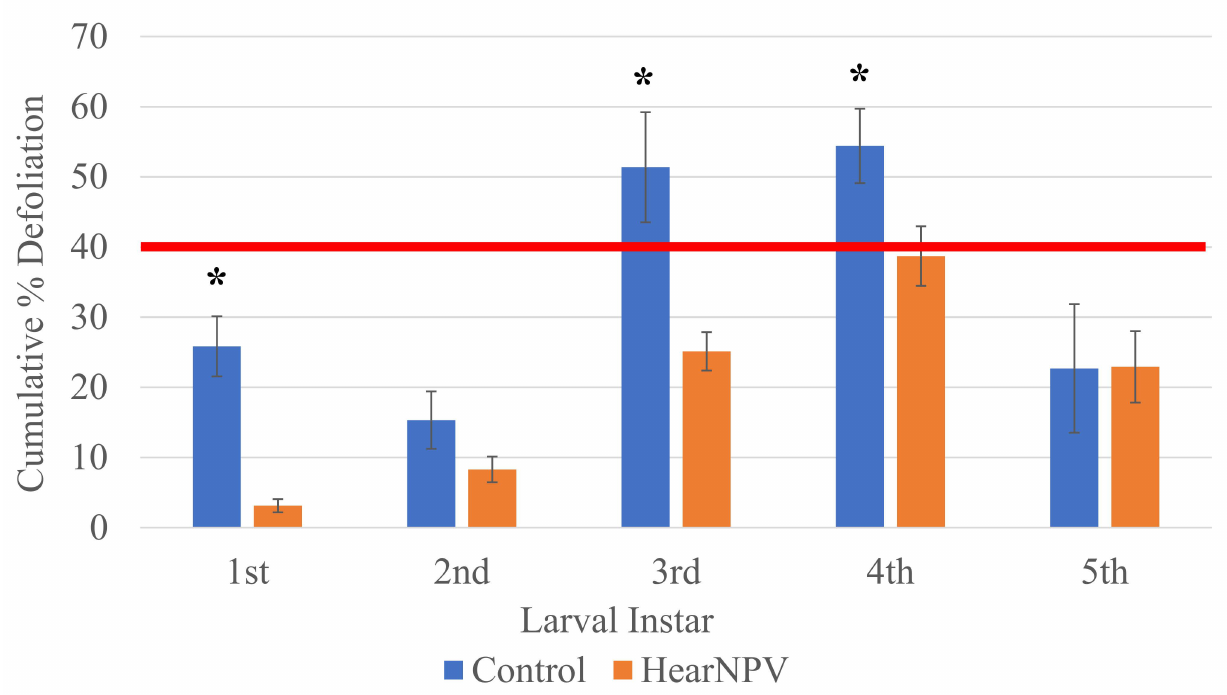
Figure 4. Determining the efficacy of Helicoverpa armigera nucleopolyhedrovirus versus the un- treated through percent defoliation across Helicoverpa zea (Lepidoptera: Noctuidae) larval instar when applied to V3 soybeans compared with the Arkansas economic threshold of 40%. * Denotes significant differences for that instar across treatments using ANOVA ( α = 0.05) and Tukey’s post hoc analysis ( p = 0.05). The red line denotes the Arkansas action threshold of 40% defoliation. A duration of 14 days after the initial application of HearNPV and infestation of H. zea